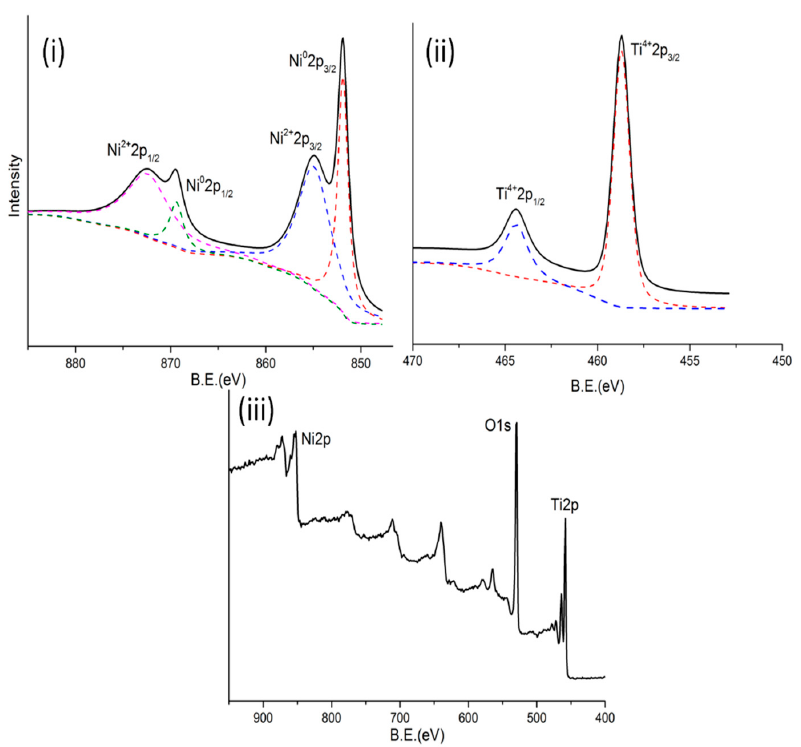
Figure 3. XPS spectra of the Ni 2p for 20 wt.% Ni/TiO 2 ( i ), and Ti 2p for the 20 wt.% Ni/TiO 2 ( ii ) and 20 wt.% Ni/TiO 2 ( iii ).